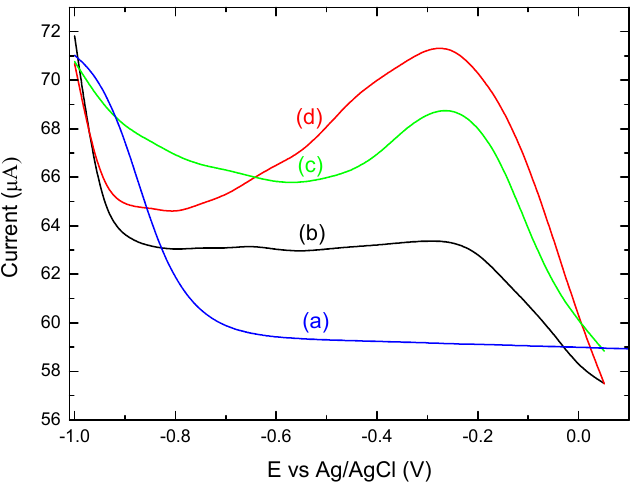
Figure 5. Differential pulse voltammetry (DPVs) comparison of (a) a bare graphite/SiO 2 film electrode, (b) (KG) 5 -MOG 35-55 , (c) mannan, and (d) OM-(KG) 5 -MOG 35-55 conjugate on graphite/SiO 2 electrode in 10 mM NaH 2 PO 4 , pH 7.0. 3.4. Complete Conjugation between (KG) 5 -MOG 35-55 Peptide to OM is Monitored by